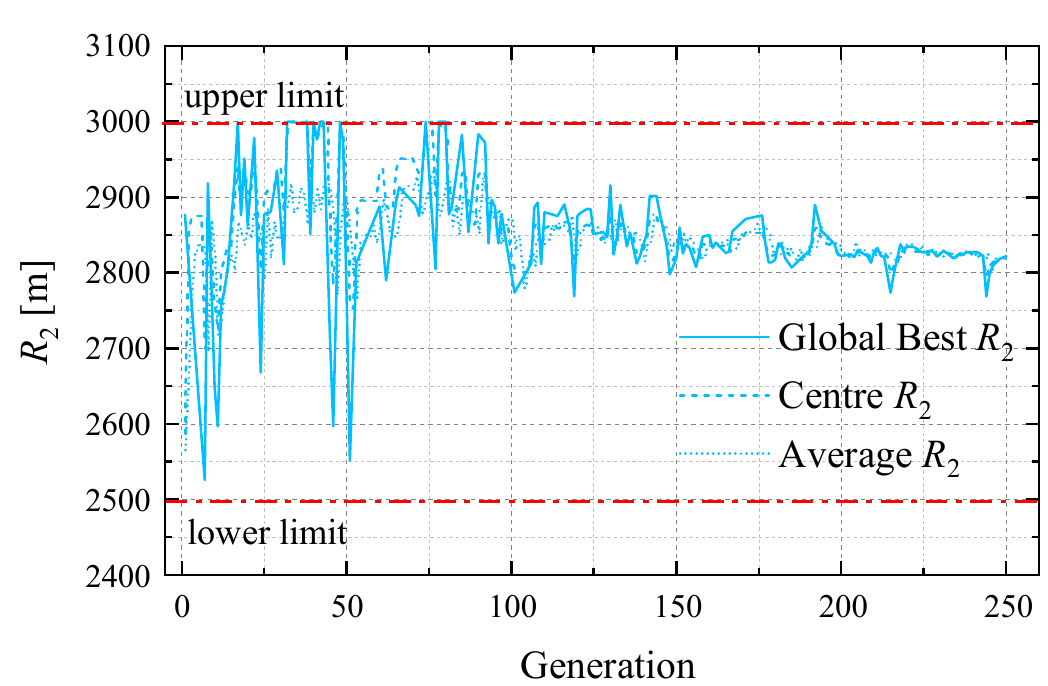
Figure 18. The convergence progress of radius of entry curved segment: R 2.